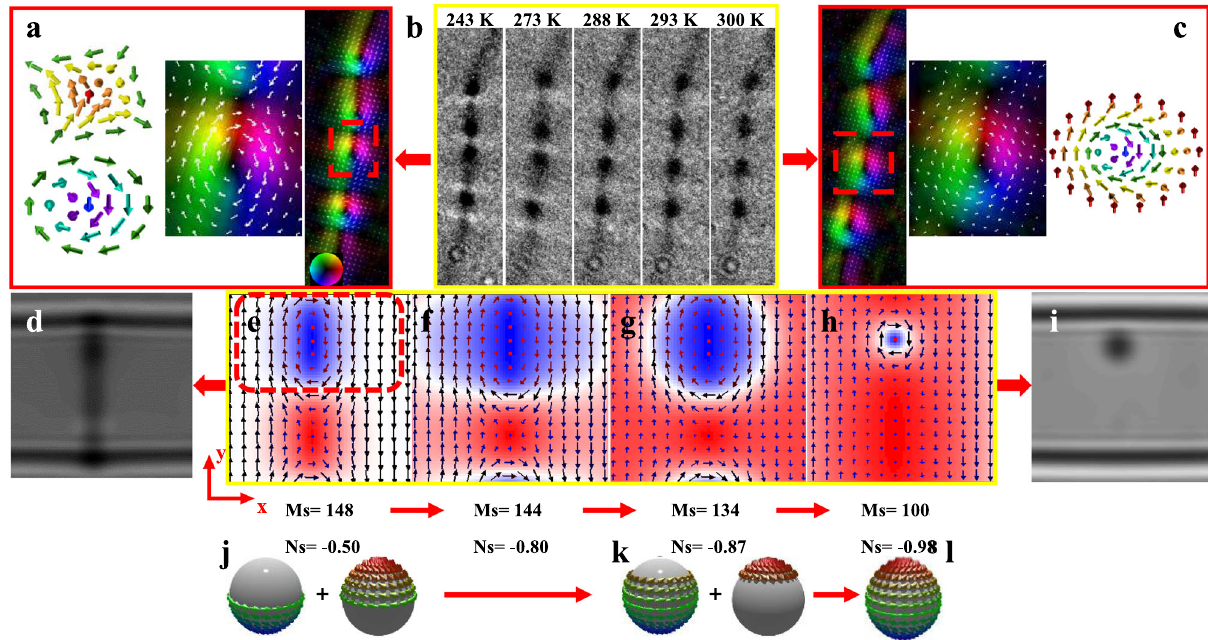
Fig. 2 The topology identi fi cation of the spin textures in the domain wall of the thin fi lm. a Schematic meron pair and the lateral magnetic component distributions were deduced from the selected domain wall region at 243 K by using the transport-of-intensity equation (TIE) analysis. The color wheel for the direction of in-plane magnetization is displayed in the inset. b The magni fi ed images from the selected domain wall demonstrating the evolution from meron pairs with alternated dark and white contrast into skyrmions with single dark contrast in the domain wall at 300 K. c The in-plane magnetic component distributions and schematic view of skyrmions deduced from the selected domain wall at 300 K. d and i The corresponding L-TEM contrast simulation. e – h The simulated domain wall evolution from the meron pair to skyrmion. The value of skyrmion number ( N s ) is integrated across half distance of y -direction (the dotted rectangle in e ) and the value ranging from − 0.5 to − 0.98 con fi rms the topological transformation from meron to skyrmion. The out-of-plane magnetization is represented by regions in red ( + m z ) and blue ( − m z ), whereas the in-plane magnetization is represented by white regions with black arrows. j – l The corresponding schematic stereographic projection of spin textures. The axis in the left corner stands for the corresponding direction used in our main